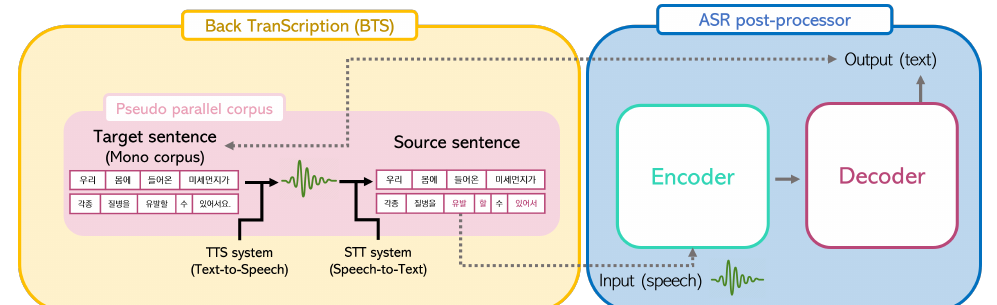
Figure 1. Architecture of the ASR post-processor and BTS. The red-colored words in the source sentence indicate ungrammatical words. The following example means “Fine dustoccurs many diseases when it comes to our bo” from the source sentence and means “fine dust occurs many diseases when it comes to our body” from the target